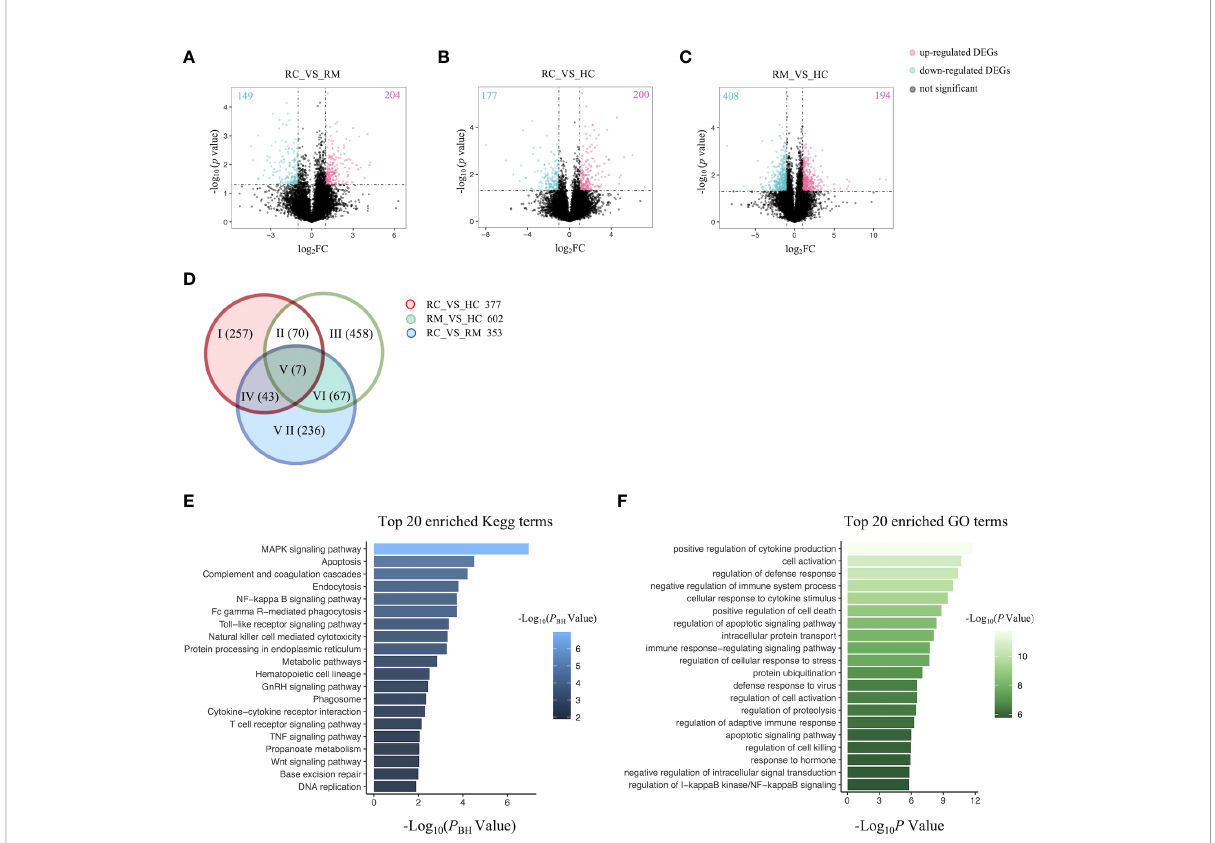
FIGURE 3 Identi fi cation of DEGs related to recurrence of FSGS after kidney transplantation.Volcano plot showing DEGs between (A) RC group and RM group; (B) RC group and HC group; (C) RM group and HC group. Each dot represents a gene. Red dots represent up-regulate genes, green dots represent down regulated genes. The numbers marked in the upper left and upper right corner represents the number of DEGs. (D) Venn diagram showing overlap of DEGs identi fi ed by pairwise comparison among the three groups. Top 20 enriched (E) Kegg terms and (F) GO terms. RC, recurrence; RM, remission; HC, healthy